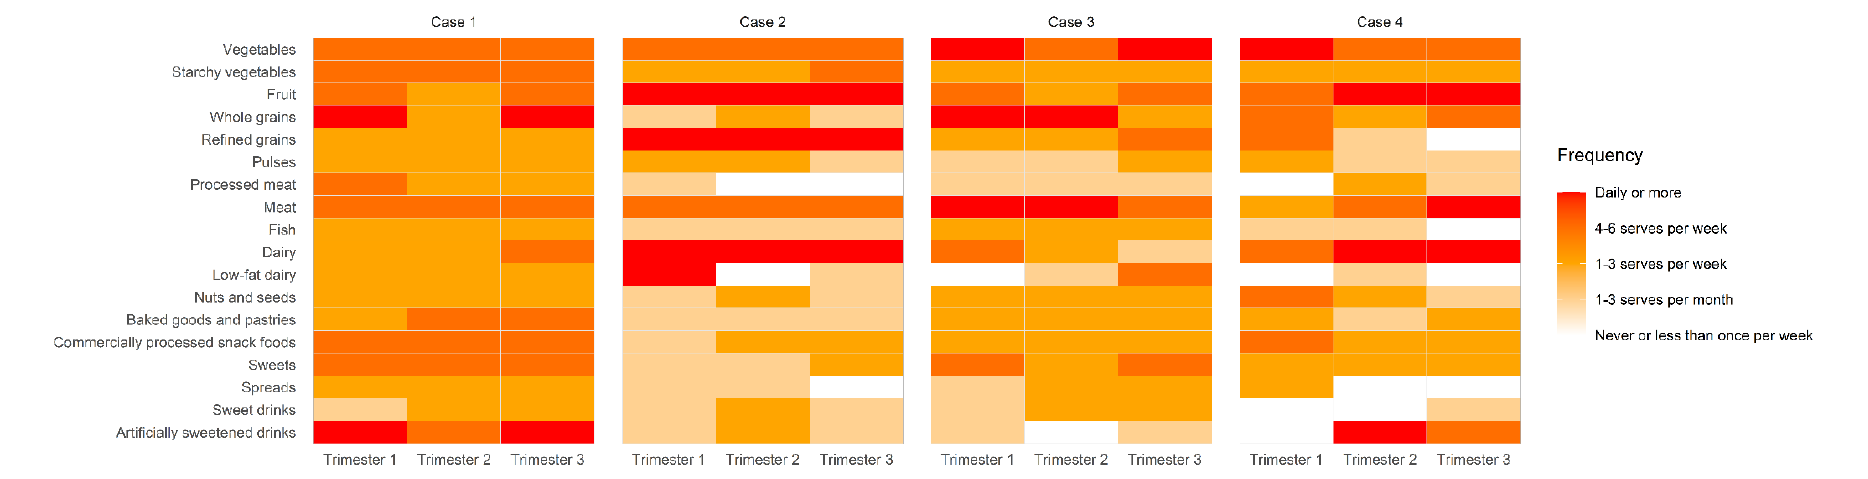
Figure 1-A1: Heat map representing change in the consumption frequency of certain types of